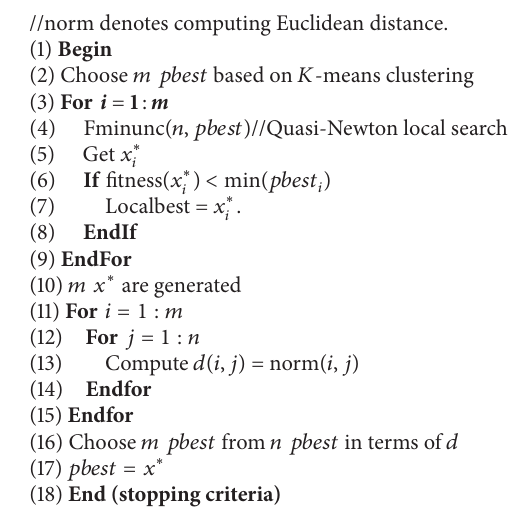
Algorithm 1: Quasi-Newton local